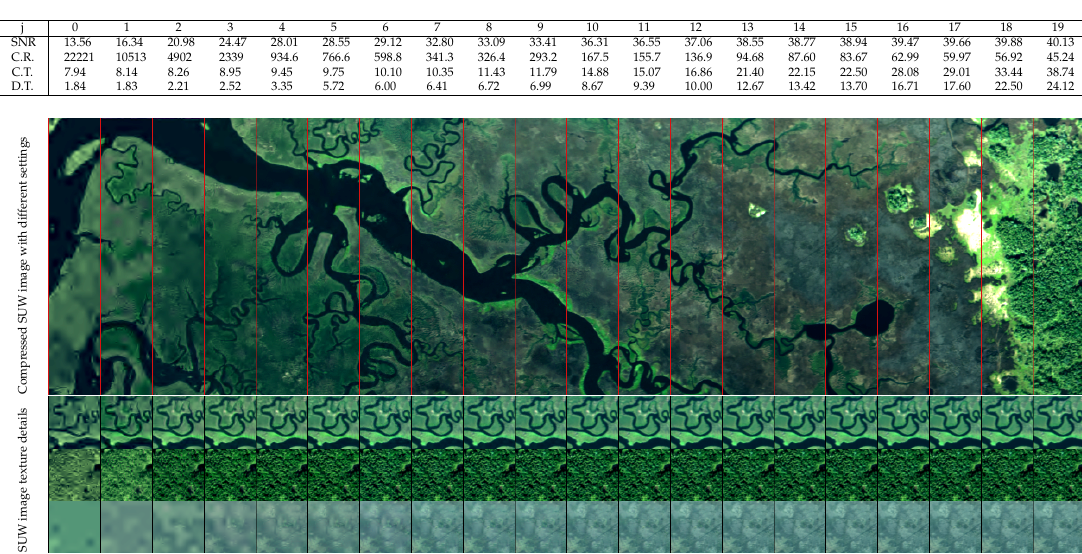
Figure 7. Distortion-ratio results for the optimal parameters from configurations F ( j ) , j = 0, . . . ,19